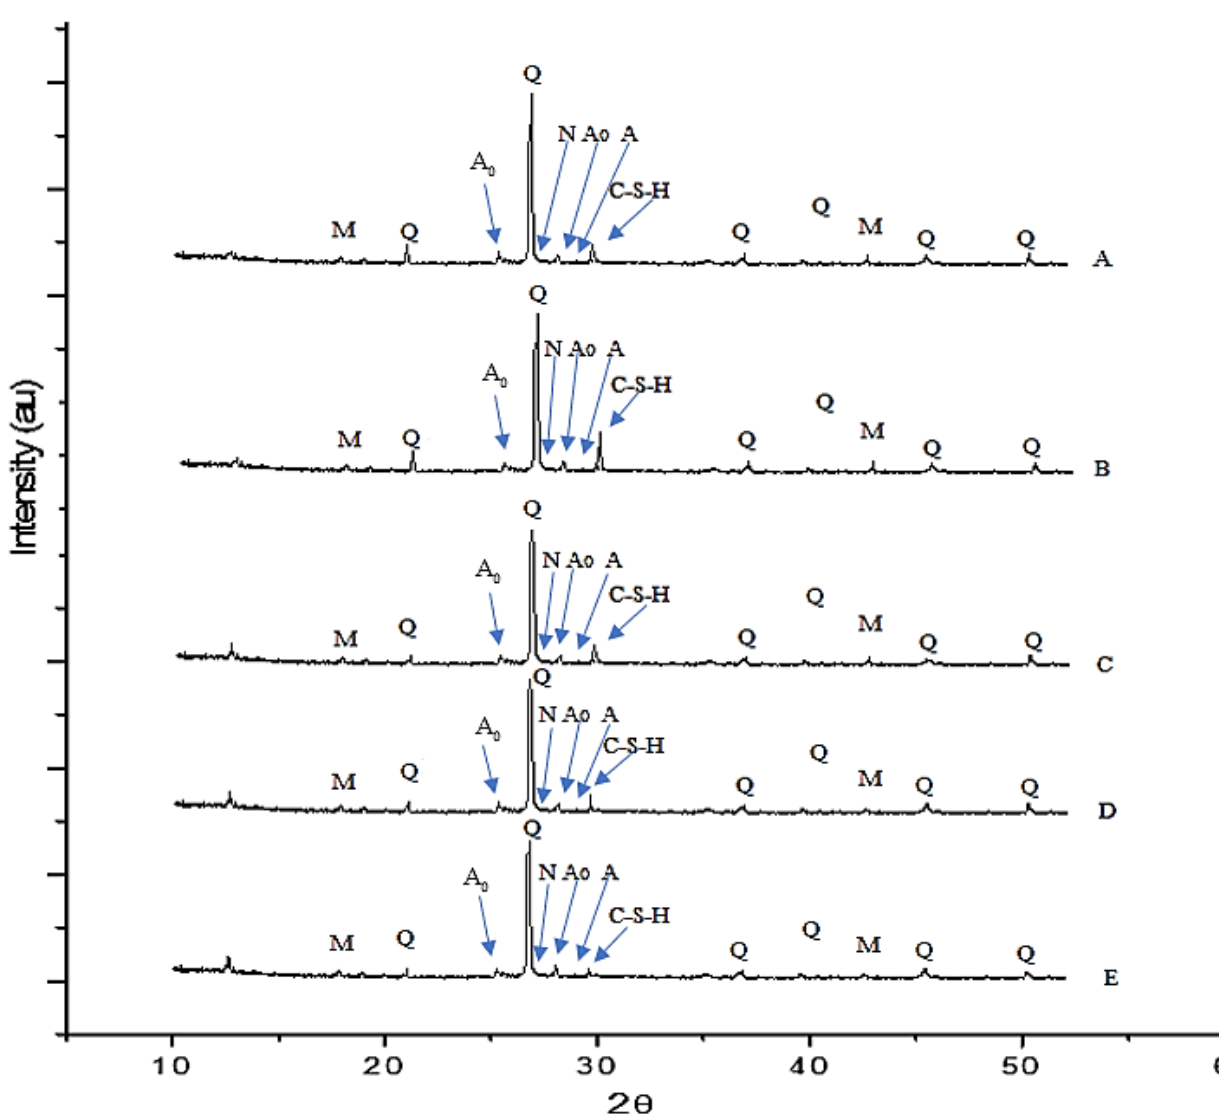
Figure 19. XRD analysis of the geopolymer material of Series C mix design using various SS-to-SH (%) ratios from 0 to 30% and an FA-to-GGBS ratio of 1:3 with sand preheated at 110 ◦ C and cured in a hot oven at a constant temperature of 50 ◦ C for 3 h and 1 d room-temperature curing. A: SS/SH-0%; B: SS/SH-5%; C: SS/SH-10%; D: SS/SH-20%; E: SS/SH-30%. SS: sodium silicate solution (Na 2 SiO 3 ); SH: sodium hydroxide (NaOH); Q: quartz; M: mullite; A: albite; N: nepheline; A 0 : anorthoclase.